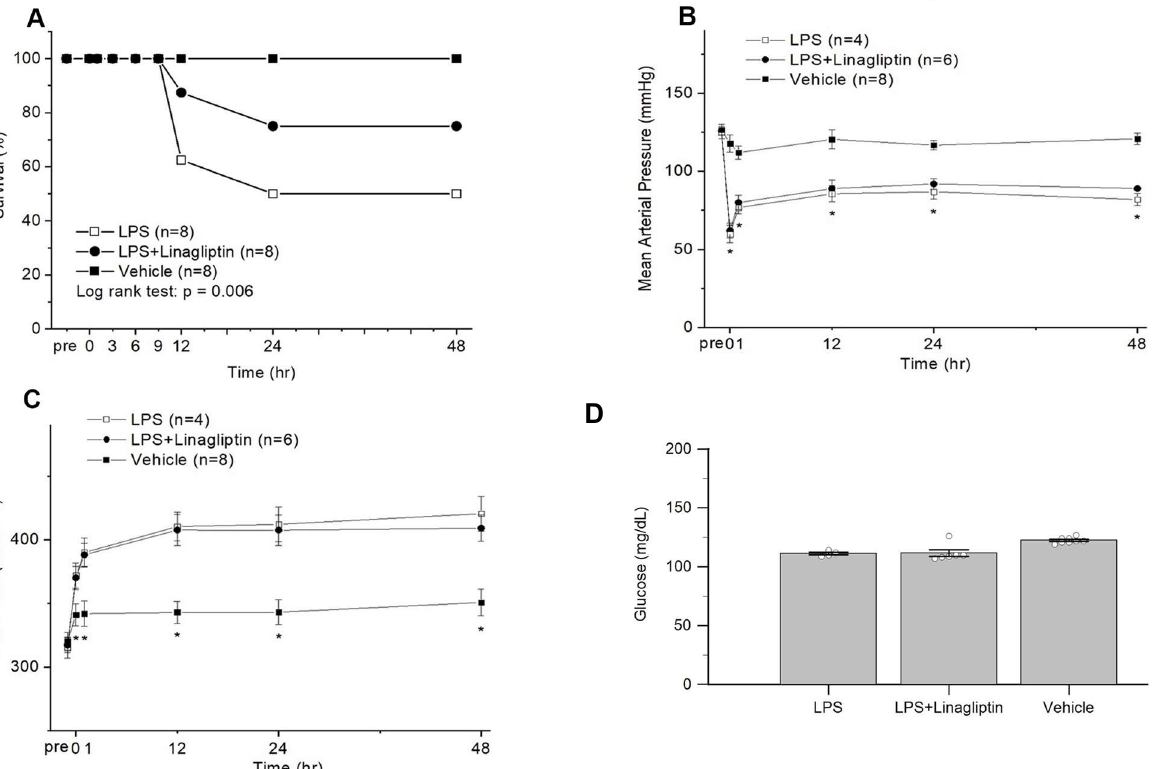
Figure 4. Changes in ( A ) survival curves, ( B ) mean arterial pressure, ( C ) heart rate, and ( D ) glucose after endotoxic shock in conscious rats. * p < 0.05 for the LPS group compared with the Vehicle group. Vehicle ( n = 8), LPS ( n = 4), and LPS + Linagliptin ( n = 6) groups at 48 h after LPS administration.